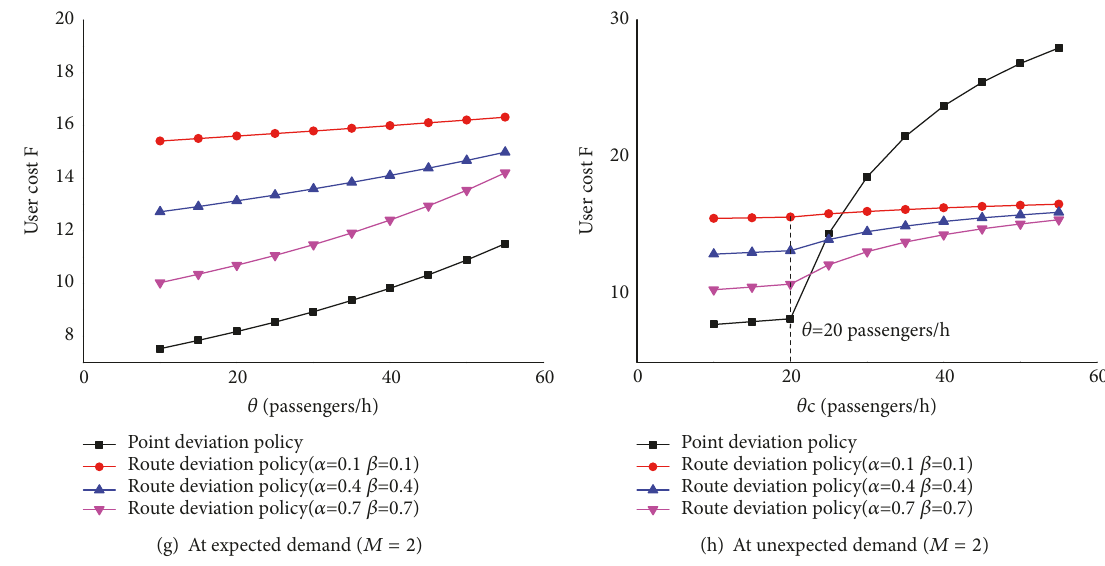
Figure 6: Sensitivity analysis for different